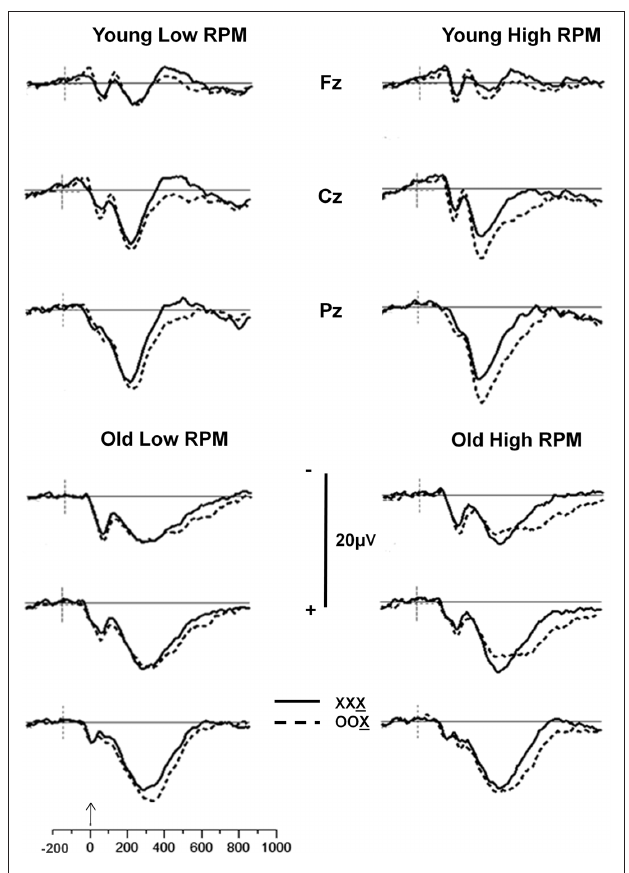
Figure 3 | grand average waveforms of stimulus X as a function of the preceding two stimuli for the Fz, Cz, and Pz electrode sites for younger and older adults split into high- and low-rPM groups. Solid line: no change condition (XXX, where X is the current stimulus); dashed line: most extreme change condition (OOX, where X is the current